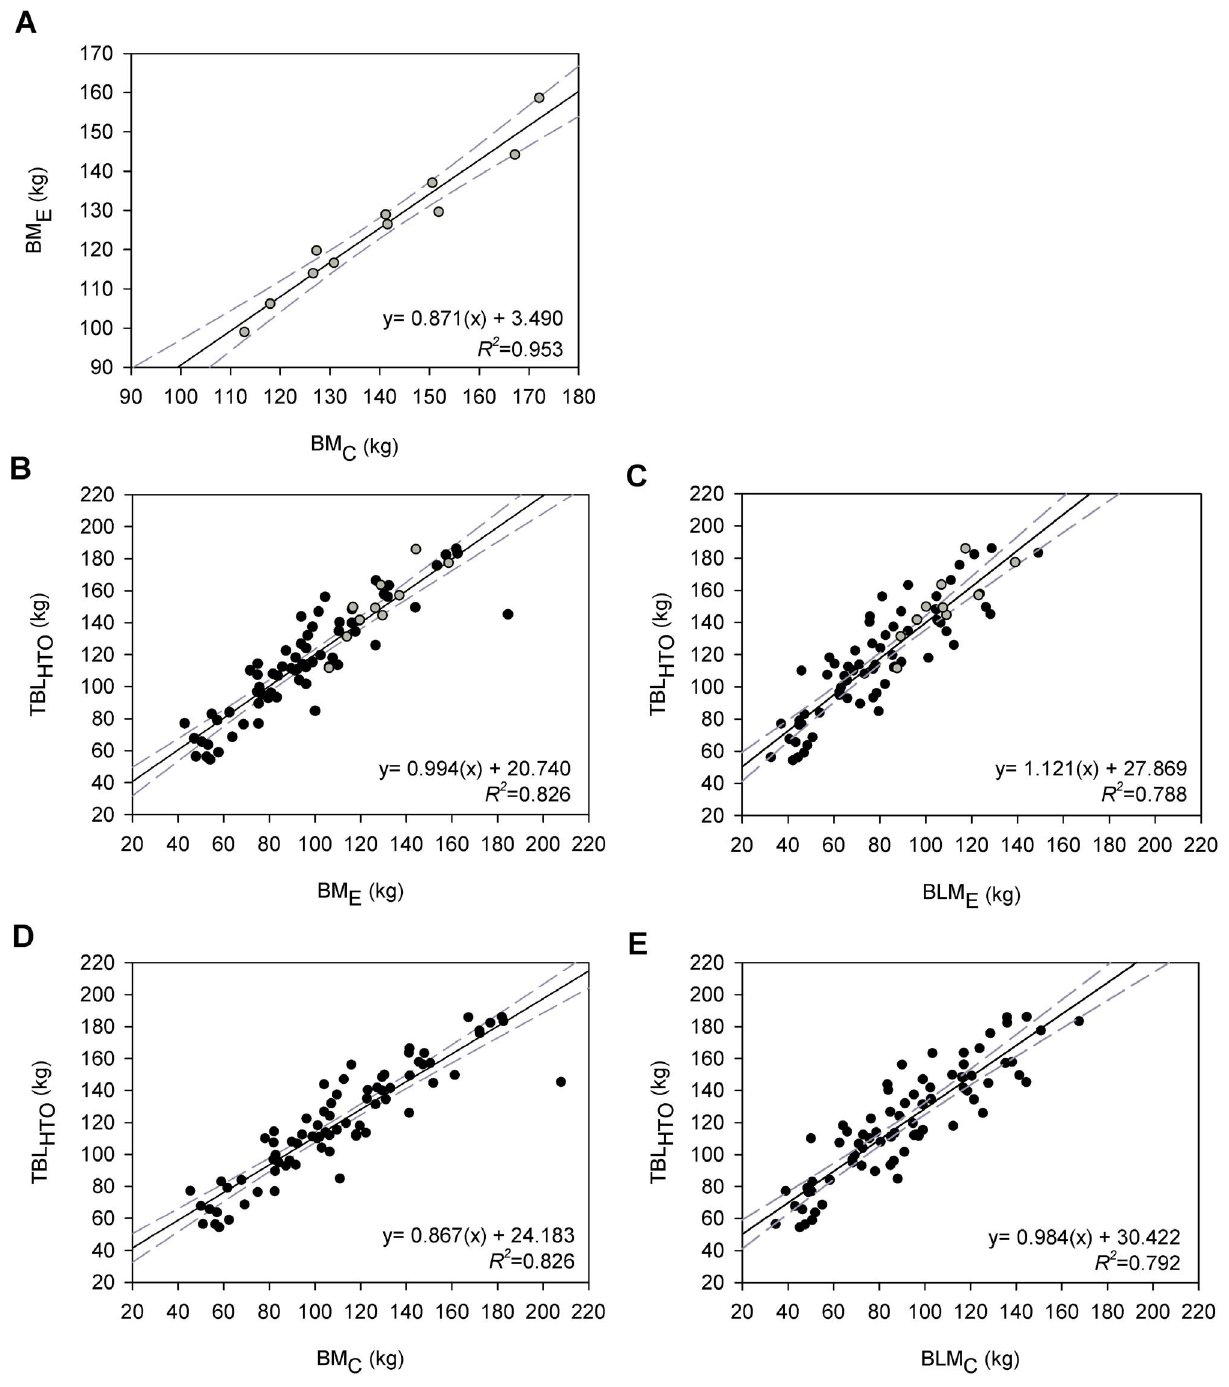
Figure 5. Relationships between morphometric and isotopic dilution body composition results. Linear regression between blubber mass determined using ( A ) elliptical and circular truncated cones ( N =11). Once this relationship ( grey ) was used to correct values to elliptical models for additional animals ( black ), regressions were made between lipid mass determined by HTO measurements and elliptical cones with ( B ) and without ( C ) corrections for blubber lipid content. Similar relationships exist when using traditional, circular truncated cones with ( D ) and without ( E ) corrections for blubber lipid content ( N =76). doi:10.1371/journal.pone.0091233.g005 truncated cone models underestimated lipid stores measured by truncated cones model using circular animal cross-sections using isotopic dilution techniques. significantly overestimated M T and BM (absolute and as %M T ), relative to elliptical cones. Still, both the circular and elliptical That body lipid stores determined by isotopic dilution techniques (TBL HTO ) are consistently higher than blubber lipid